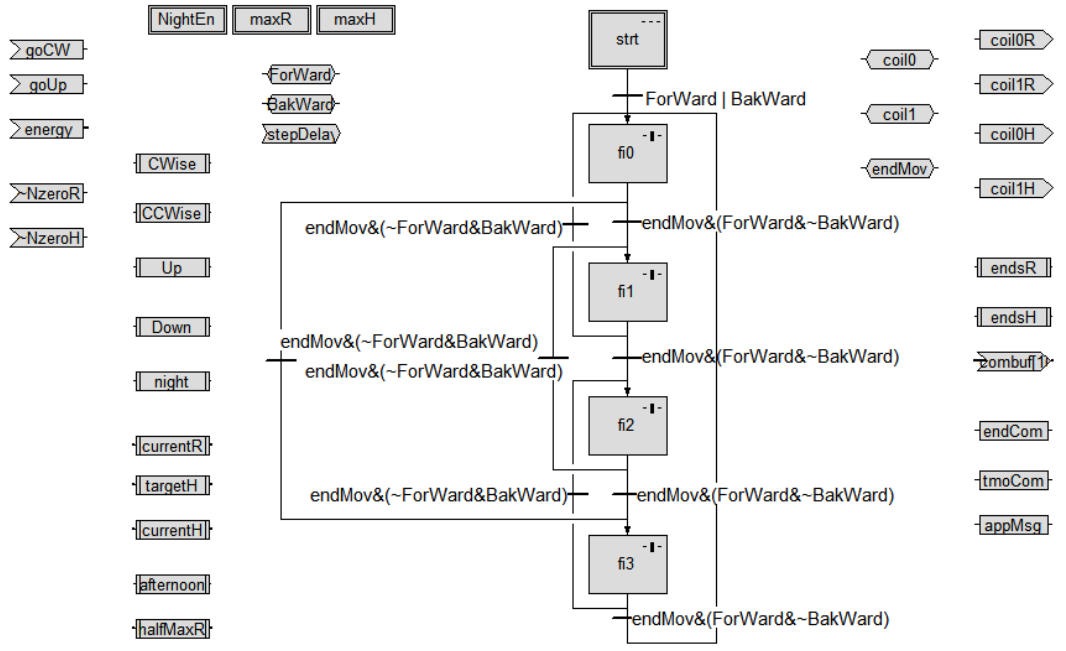
Figure 5. The Control Flow model of the StepMot